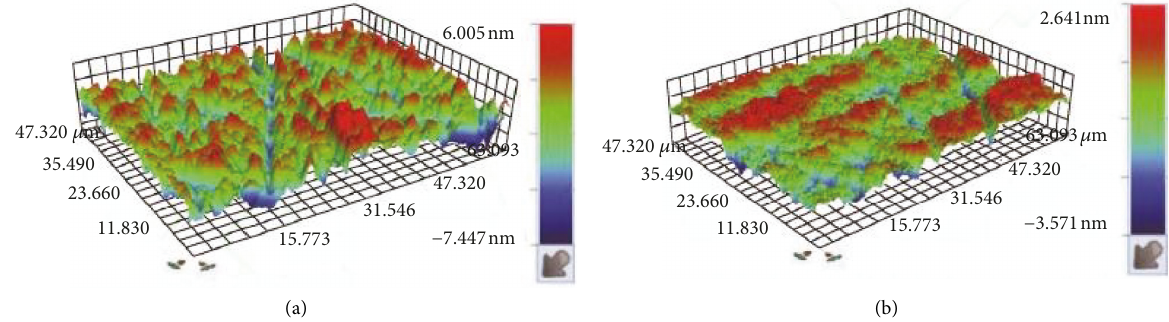
Figure 28: Surface morphology of sapphire wafer processed by different methods [155]. (a) Conventional cluster magnetorheological finishing. (b) Cluster magnetorheological variable gap dynamic pressure